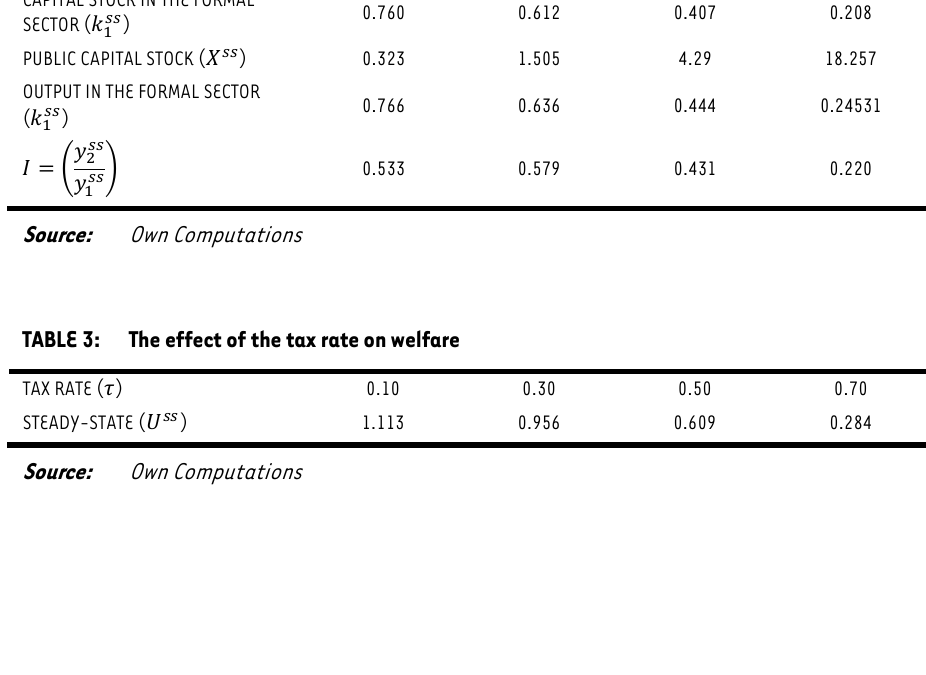
Effect of an increase in the tax rate on the relative size of the informal sector TAX RATE (